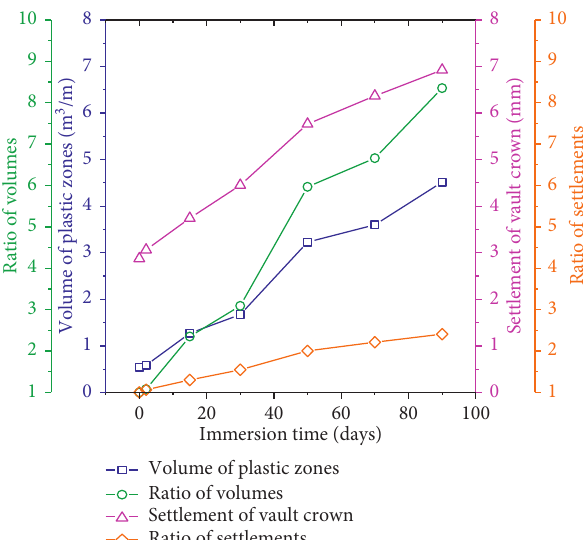
Figure 10: Volume of plastic zones and settlement of vault crown under various immersion